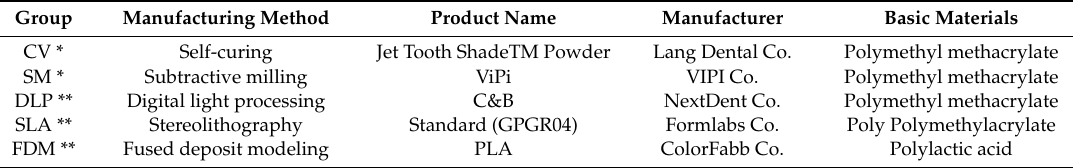
Table 2. Composition and mechanical properties of specimen